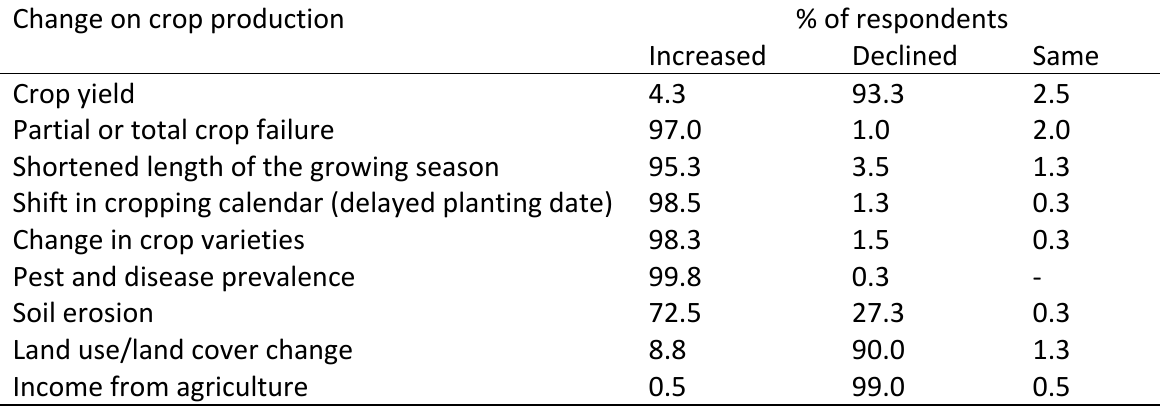
The Distribution of Farmers by the Response to the Impact of Climate Variability and Changes in Crop Production in the Previous 20 Years (2000-2019) (N = 400) Change on crop